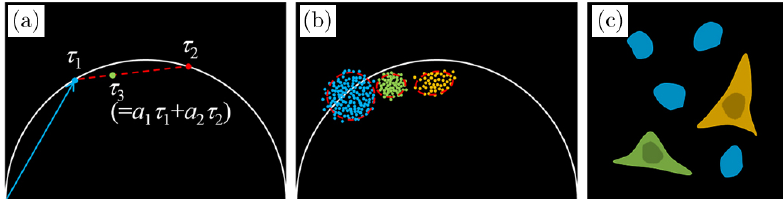
Fig. 8. Illustration of phasor analysis. (a) Pixels in a phasor plot. Phasors of pixels with single-exponential decay pro¯les locate on a semicircle (e.g., (cid:1) 1 , (cid:1) 2 Þ ; phasor of pixels with multi-exponential decay pro¯les locate inside the semicircle (e.g., (cid:1) 3 Þ . (b) Pixels with similar phasor form clusters in the phasor plot. (c) Lifetime image of cells with di®erent °uorescence lifetime. Colors correspond to di®erent phasor